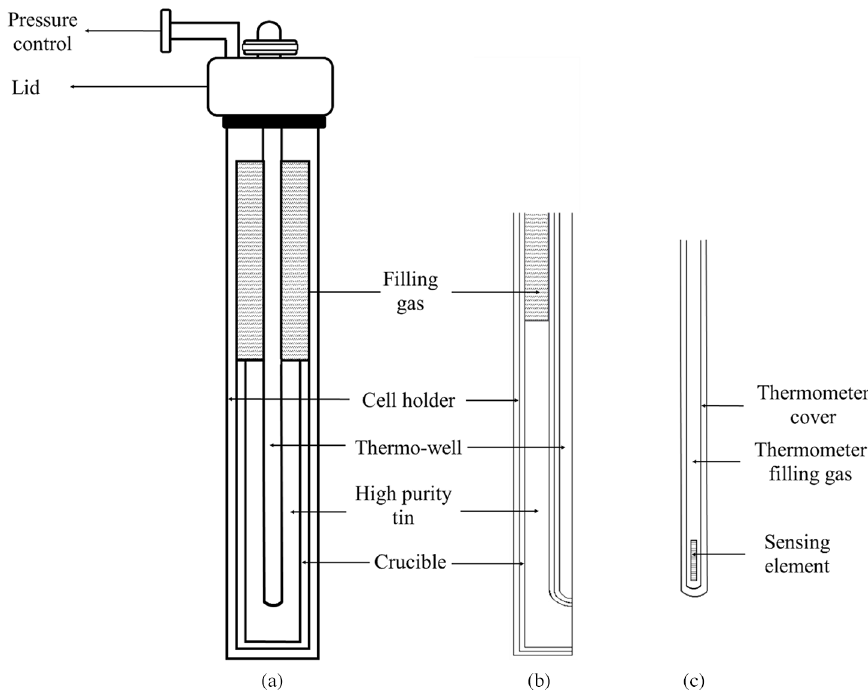
Fig. 2. Fixed-point cell assembly model, (a) main components, (b) cell model, (c) thermometer